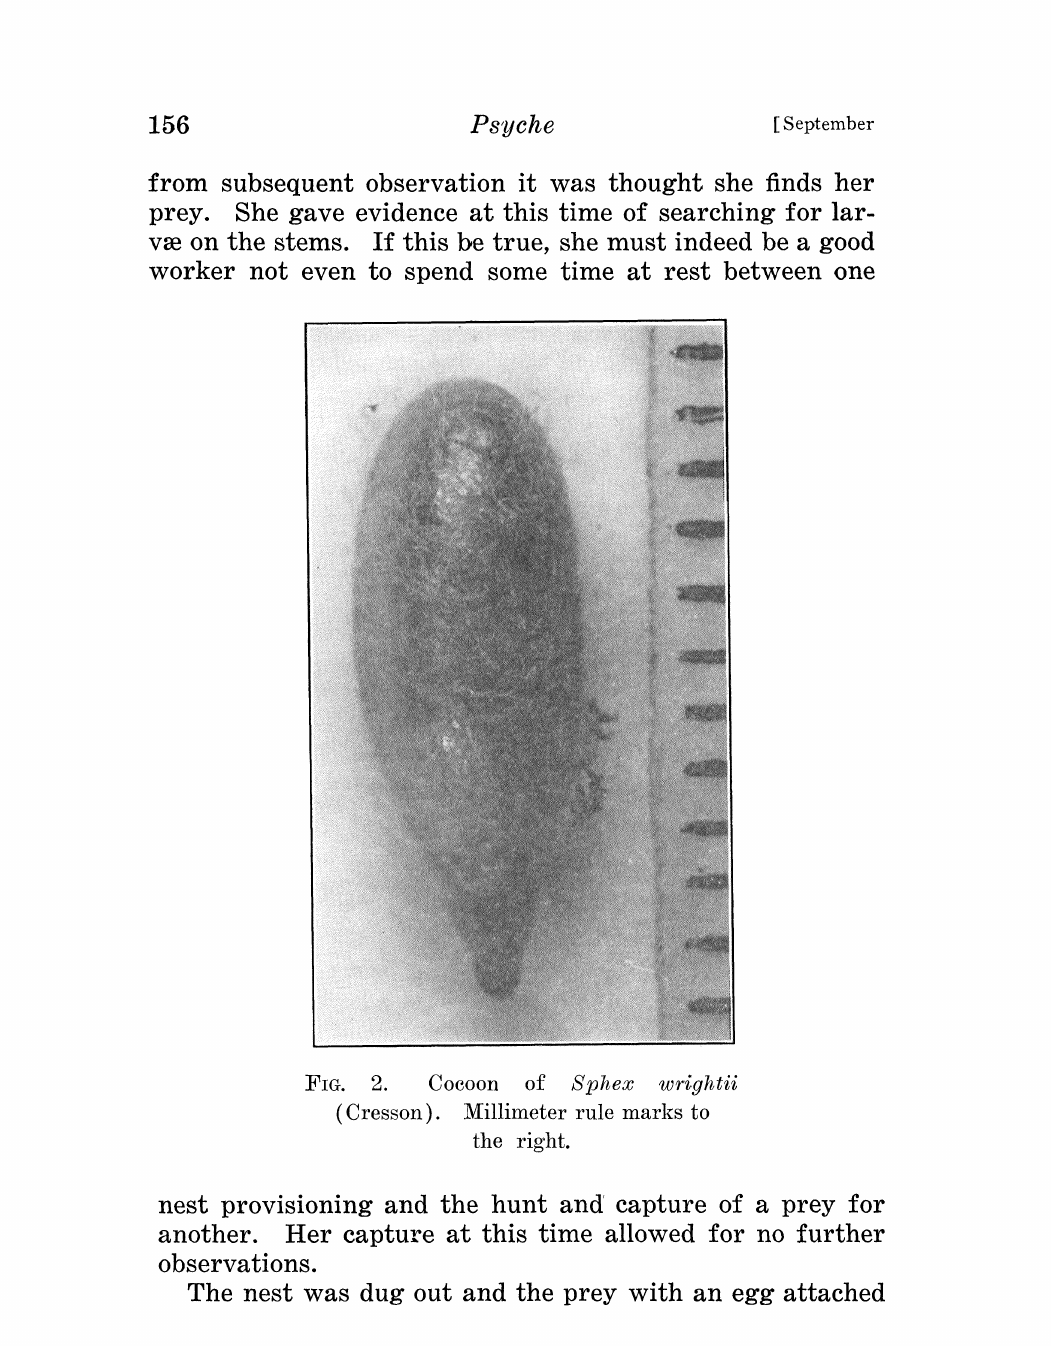
0iG. 2. Cocoon of Sphex wrightii (Cresson). Millimeter rule marks to the